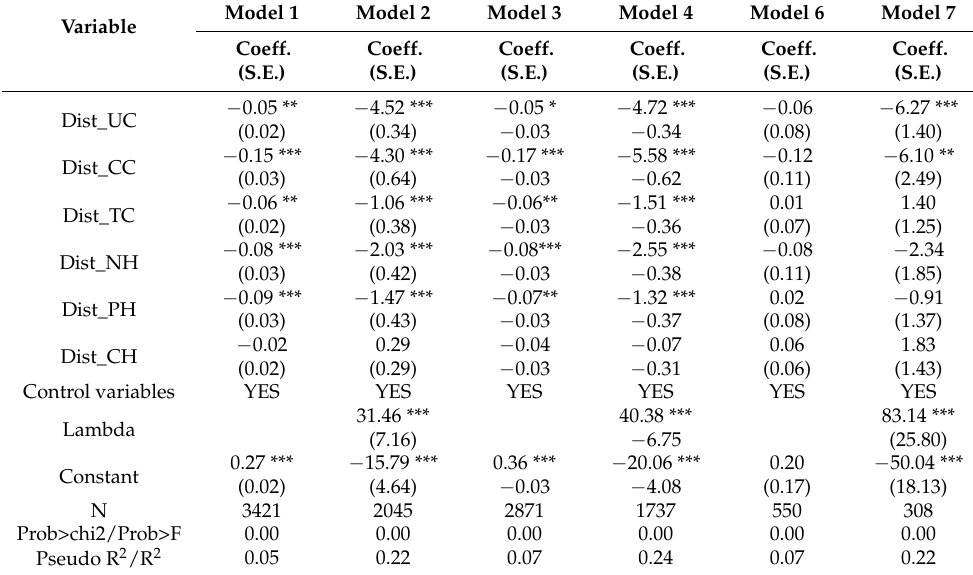
Table 4. Robustness test of the effect of multilevel location on farmland abandonment.